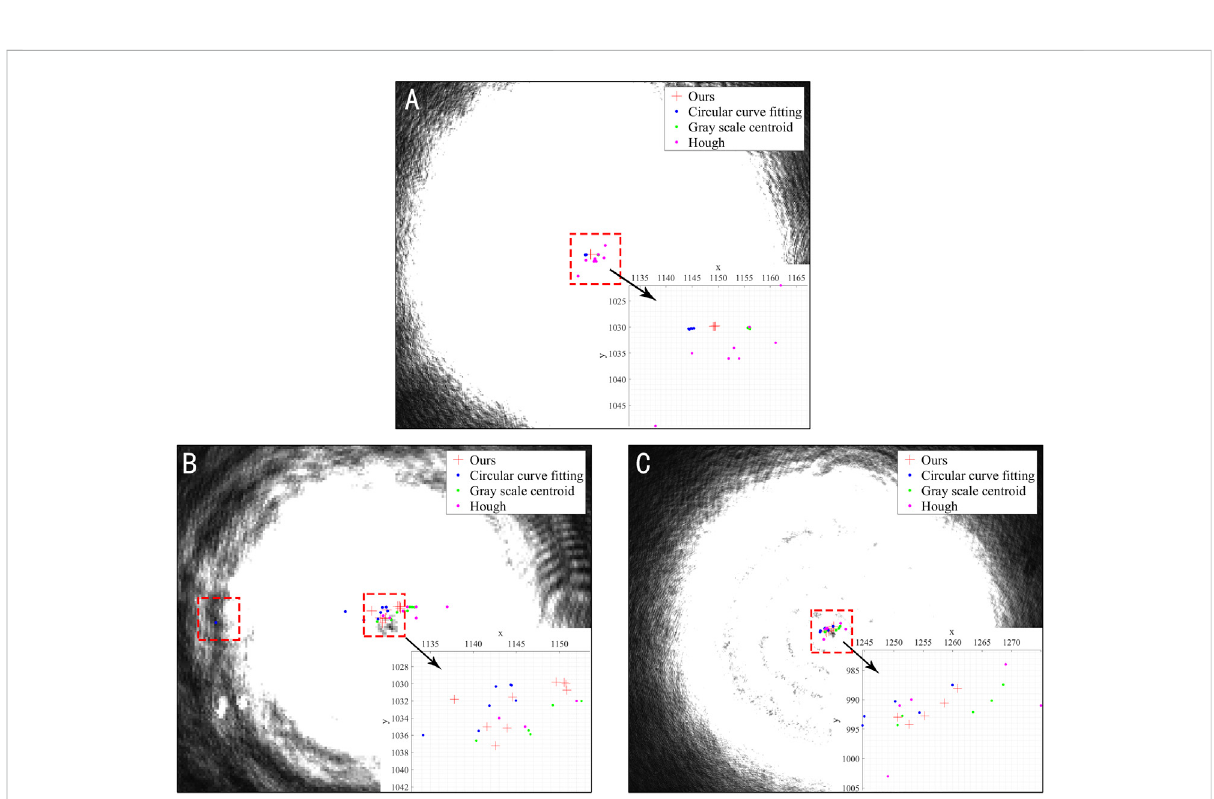
FIGURE 6 Experimental results under the stationary spot position. (A) : Different time at the same position; (B) : Different sizes at the same position; (C) : Different power at the same